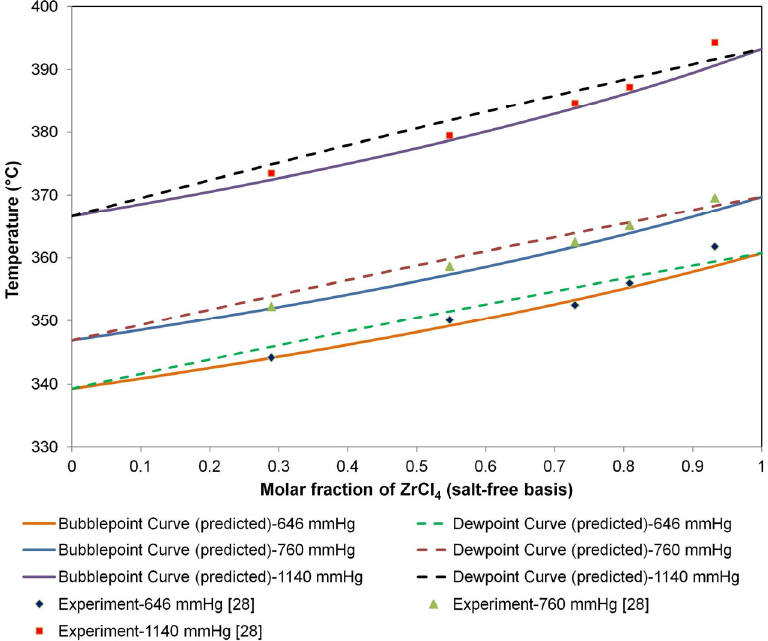
Figure 3. T-x-y diagram of the molten salt system (34.0% NaCl and KCl (8:29 M); 66.0 mol% ZrCl 4 and HfCl 4